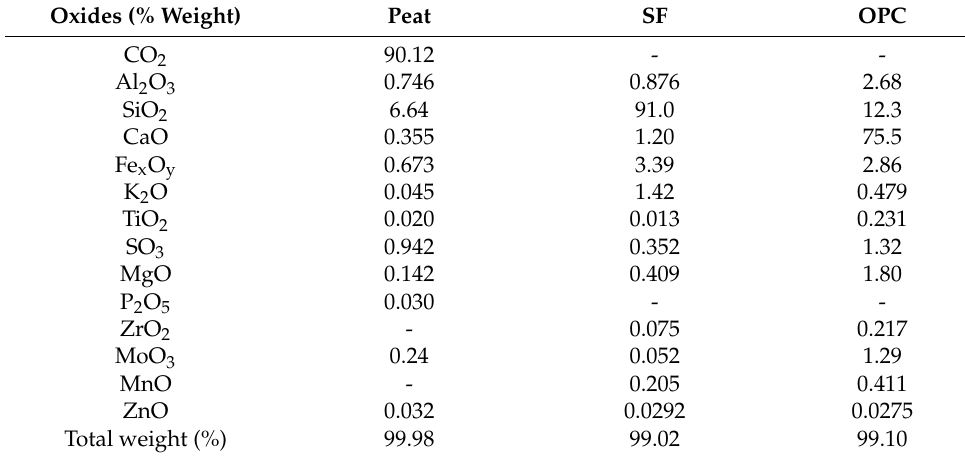
Table 3. XRF analysis of peat, SF, and OPC.